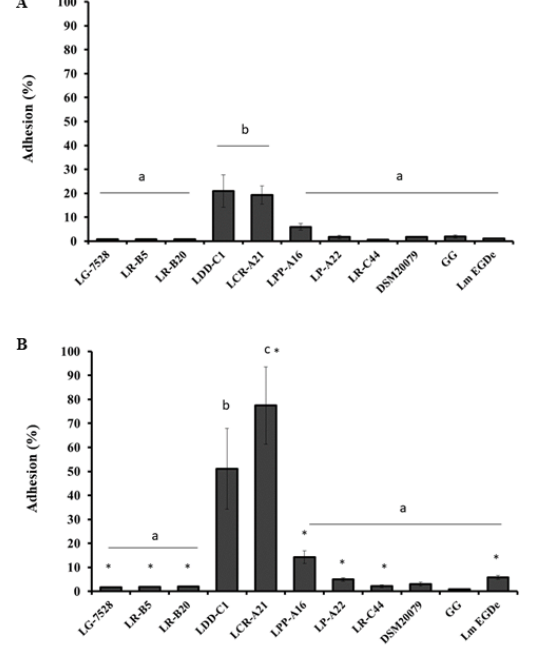
Figure 1. Adhesion efficiency (%) of the lactobacilli and L. monocytogenes strains to the Caco-2 cells following 1 h ( A ) and 2 h ( B ) of incubation. Data represent the mean values ± standard error of the mean (SEM) of three biological and two technical replicates. Different letters indicate significant differences among the strains ( p < 0.05), and asterisks indicate significant differences between 1 h and 2 h ( p < 0.05).